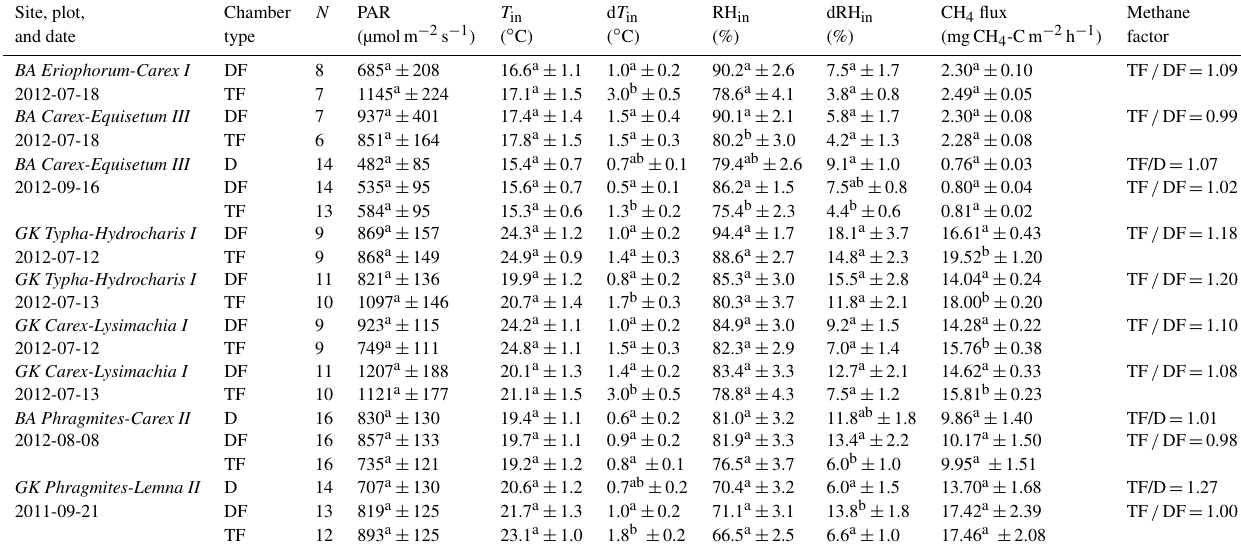
Table A2. Mean ± SD error of daytime (PAR>2µmolm − 2 s − 1 ) CH 4 flux rates, PAR, T in , and RH in by plot and chamber type (DF = opaque mixed chamber, TF = transparent mixed chamber, D = not mixed opaque chamber). Values with same letter superscript do not differ signifi- cantly at P <0.05 (Mann–Whitney or Kruskal–Wallis test; post-hoc non-parametric Nemenyi test), data of BA Phragmites-Carex II and GK Phragmites-Lemna II from Minke et al.